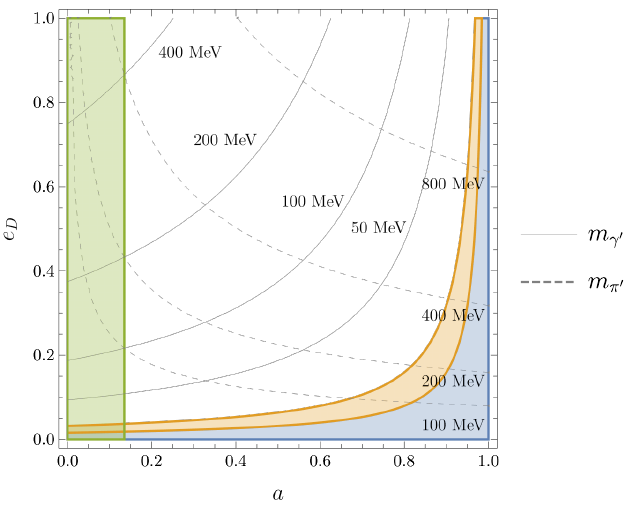
Figure 1 . The contours of the dark photon/pion masses on a ( a, e D ) plane. Here, we take m ρ 0 = m ρ × 5 ( m ρ ’ 775 MeV), which corresponds to the dark baryon mass, m p 0 ,n 0 ’ 5 – 6 GeV. The green shaded region corresponding to m is disfavored. The blue and the orange π 0 < m γ 0 shaded regions correspond to the N constraints from the current and the future CMB observa- eff tions for (cid:15) & 10 − 9